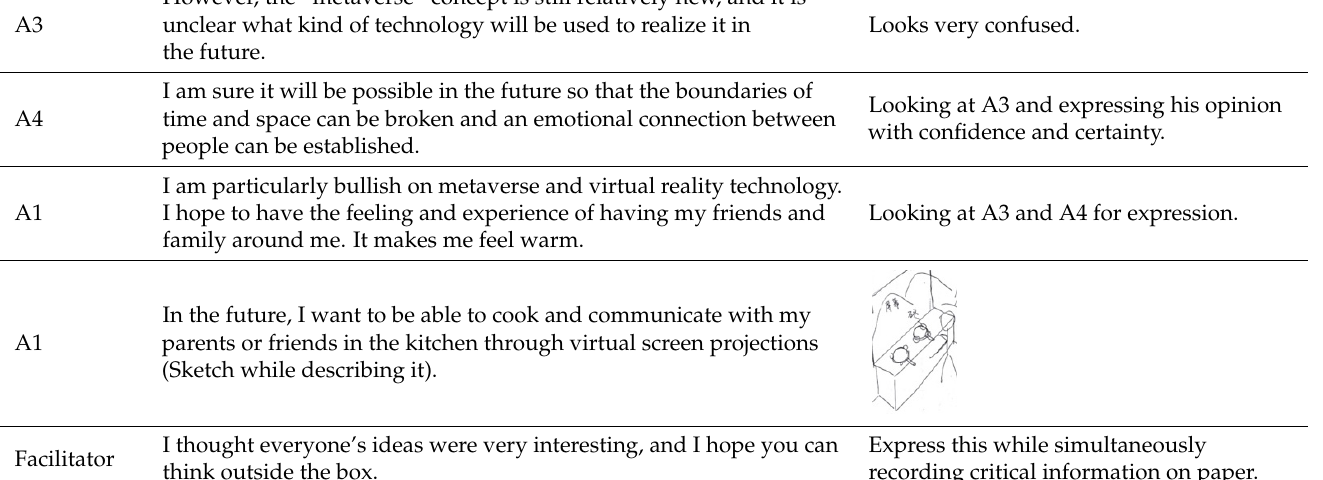
Table 3. An example of the Group Interaction and Creations